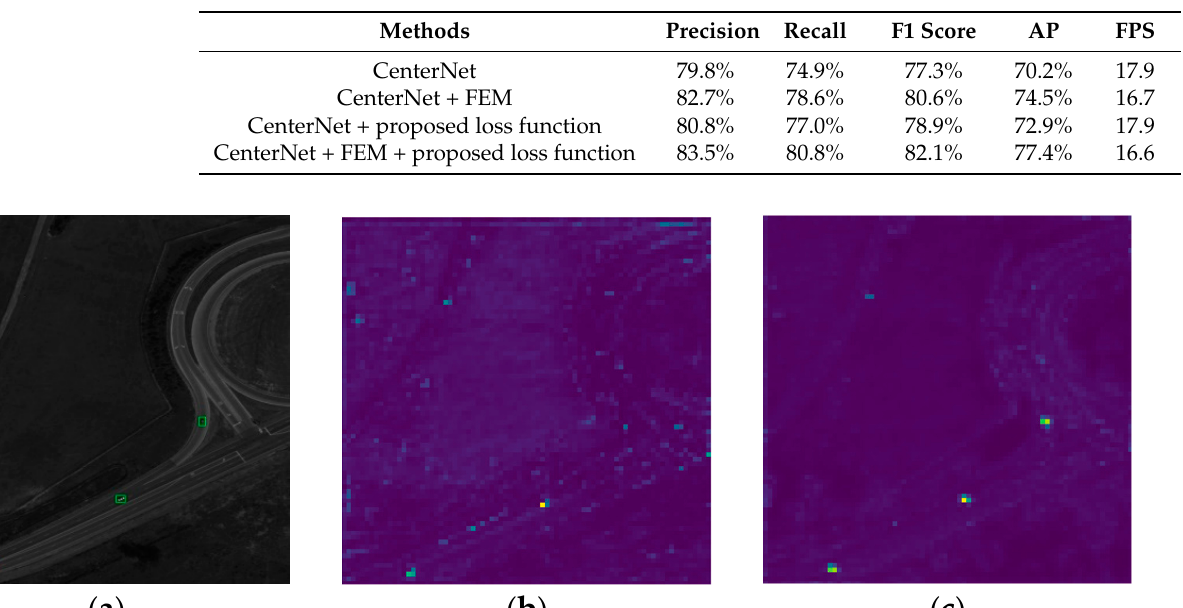
Table 1. Ablation experiments for proposed method.